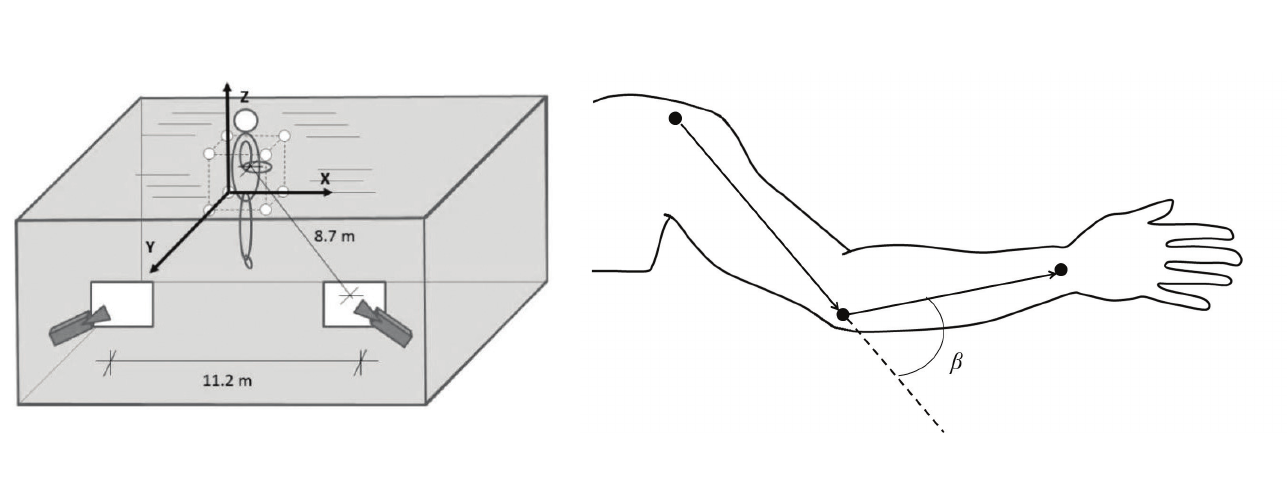
Figure 1. (a) Experimental set-up; (b) Diagram showing the points used for unit vector reconstruction of forearm and arm orientation, where β is the elbow flexion angle.